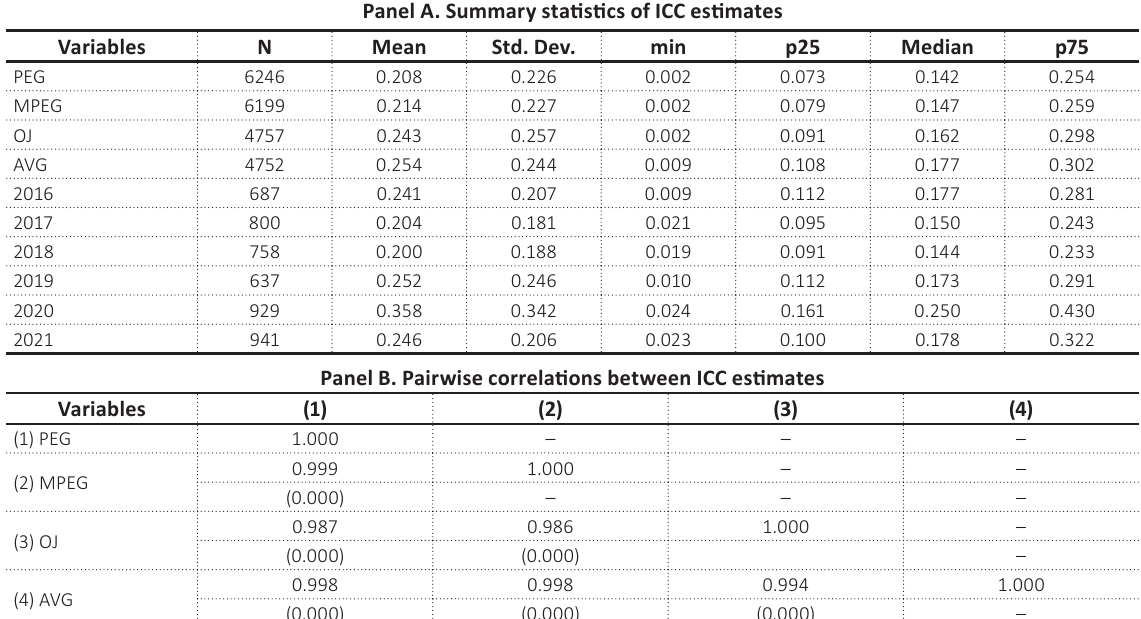
Panel B. Pairwise correlations between ICC